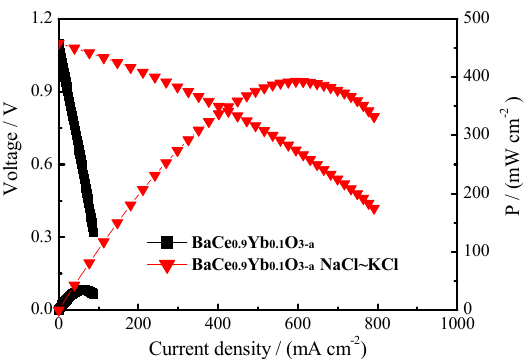
Figure 7. The I – V – P curves of BaCe 0.9 Yb 0.1 O 3 −α (1550 °C) and BaCe 0.9 Yb 0.1 O 3 −α -NaCl~KCl at 700 °C.